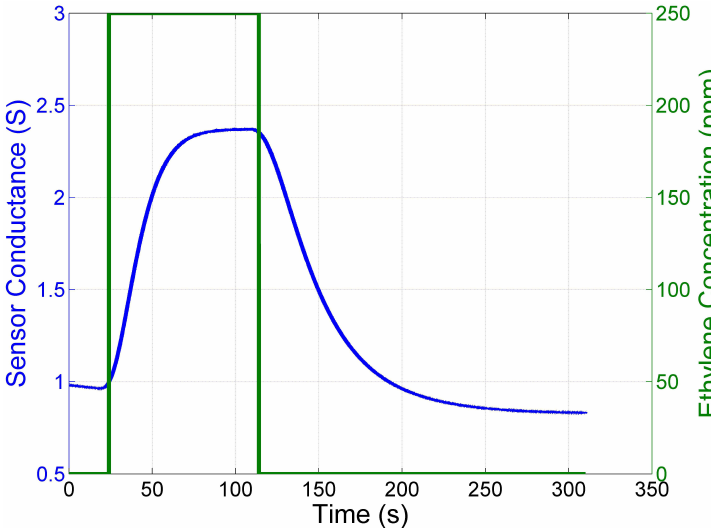
Figure 1. Response of a Figaro TGS2600 to a pulse of 250 ppm of ethylene obtained in a closed sampling